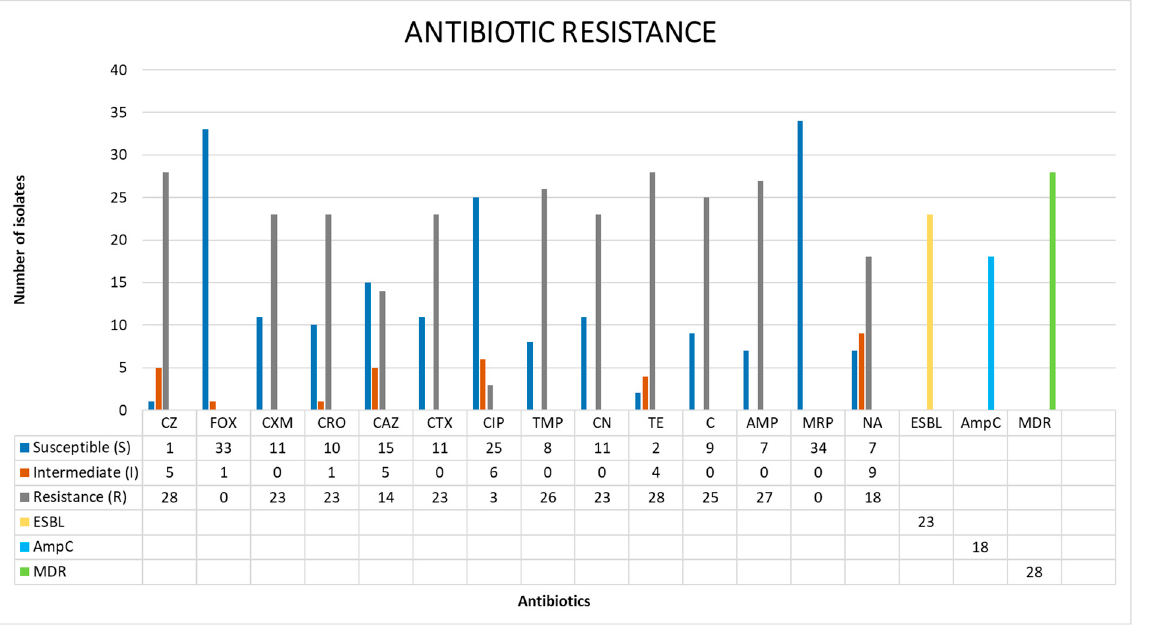
Figure 1. Antibiotic resistance profiles of duck carcass samples: cefazolin (CZ), cefoxitin (FOX), cefuroxime (CXM), ceftriaxone (CRO), ceftazidime (CAZ), cefotaxime (CTX), ciprofloxacin (CIP), trimethoprim (TMP), gentamicin (CN), tetracycline (TE), chloramphenicol (C), ampicillin (AMP), meropenem (MRP), nalidixic acid (NA), extended-spectrum beta-lactam (ESBL), AmpC β -lactamase (AmpC), and multidrug resistance (MDR).